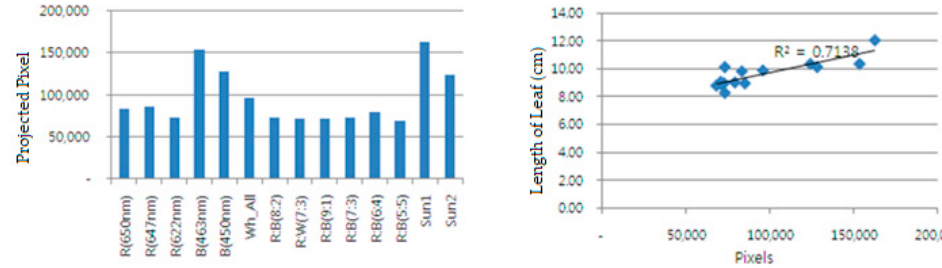
Figure 14. Comparison between growth amounts, based on image data ( left ), and the correlation between leaf length and image data ( right ).